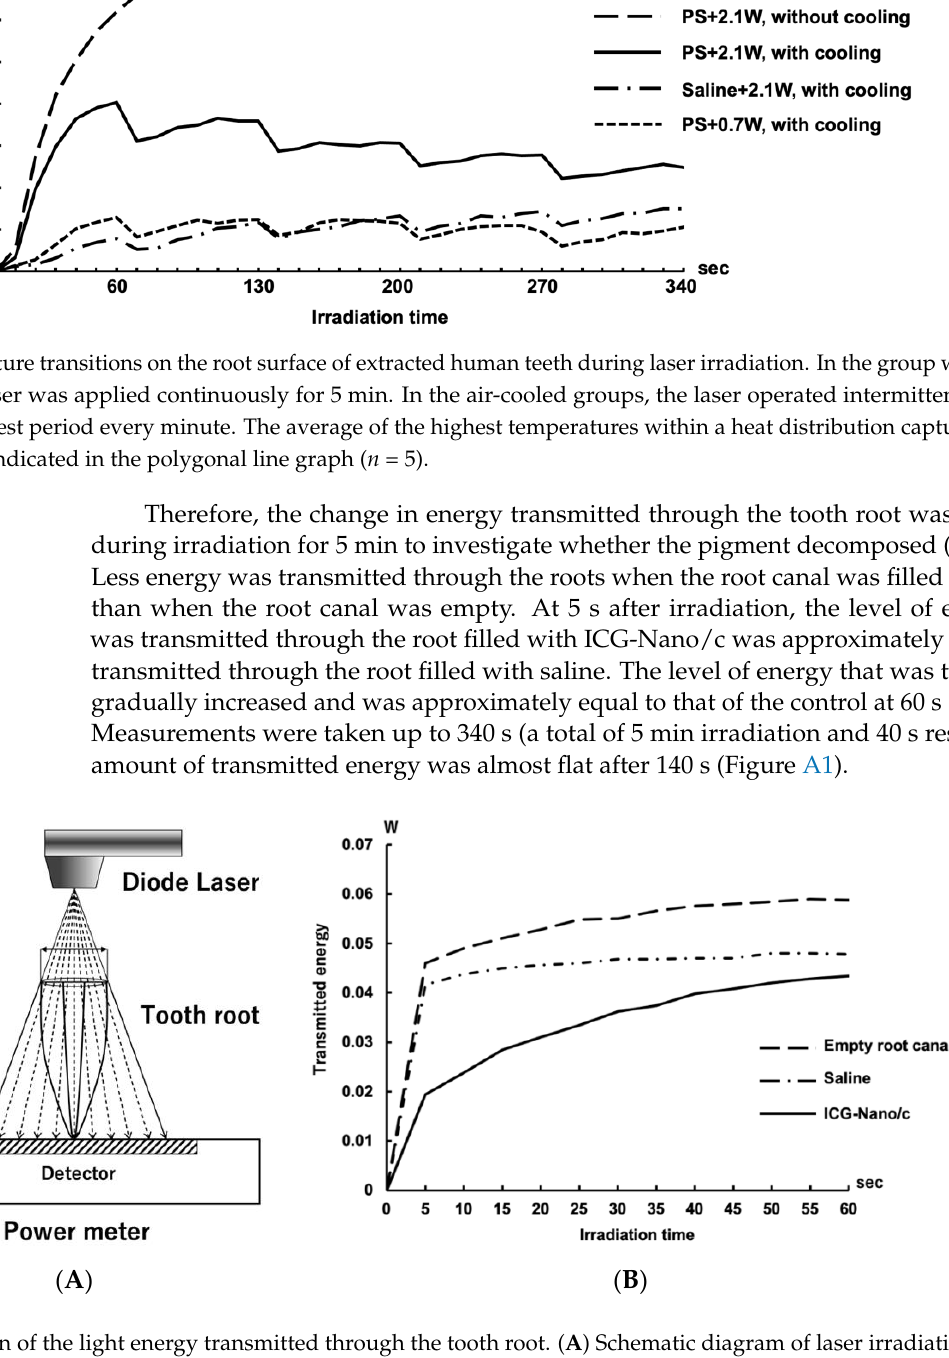
Figure 5. Temperature transitions on the root surface of extracted human teeth during laser irradi- ation. In the group without air-cooling, the laser was applied continuously for 5 min. In the air- cooled groups, the laser operated intermittently for 5 min with a 10 s rest period every minute.